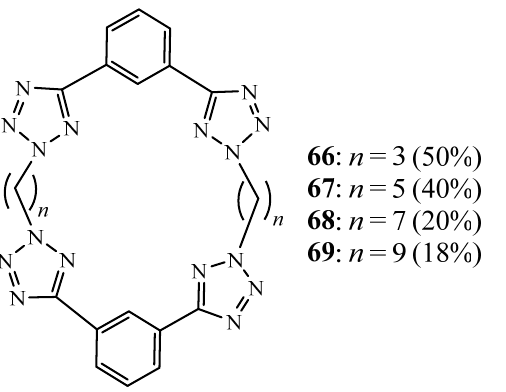
Figure 18. Tetrazolic macrocycles 66 − 69. (Reprinted with permission from ref. [33]. Copyright 2009 Elsevier).